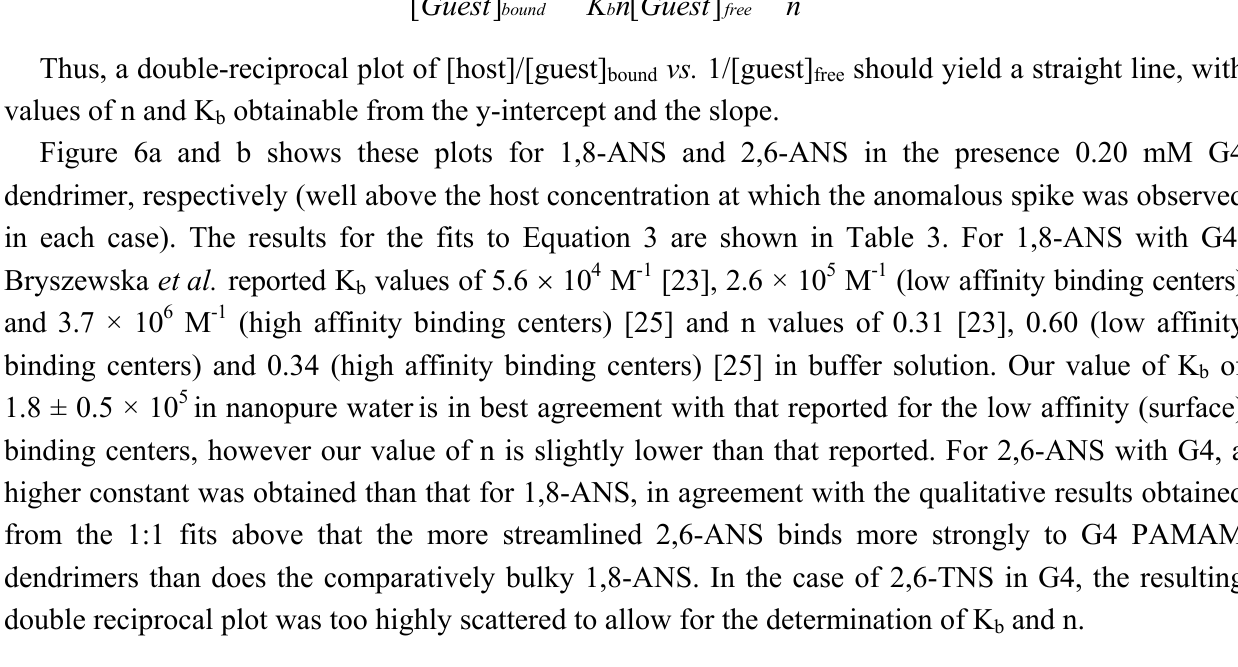
Figure 6. The double-reciprocal plots from the guest titration data for 4 × 10 -5